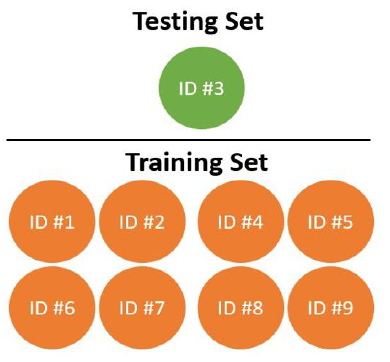
Figure 6. Illustration of the third created dataset, which is obtained by keeping all AE signals from the third tube in the testing set and AE from all other tubes in the training set. third tube in the testing set and AE from all other tubes in the training